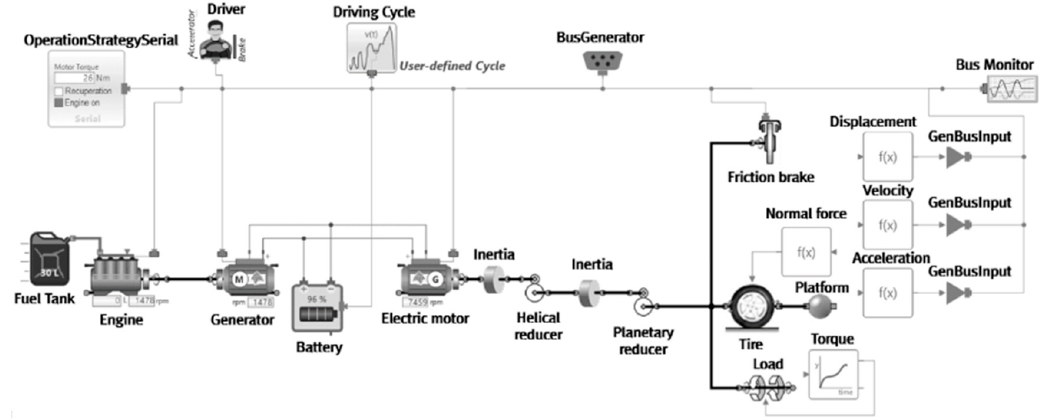
Figure3. SimulationmodelforpowertransmissionsystemoftheelectricAWDtractorusingSimulationX Figure 3. Simulation model for power transmission system of the electric AWD tractor using (reproduced from SimulationX (reproduced from [7]).